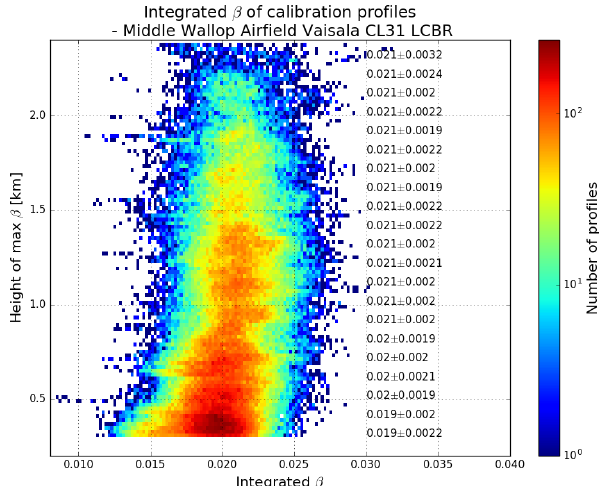
Figure 6. 2-D histogram of integrated attenuated backscatter with range, with height-dependent multiple-scattering correction ap- plied. Darker colours (towards red) indicate a higher density of pro- files. The values shown along the right-hand side give the mean ± SD of the integrated attenuated backscatter (units sr − 1 ) at 100m inter-